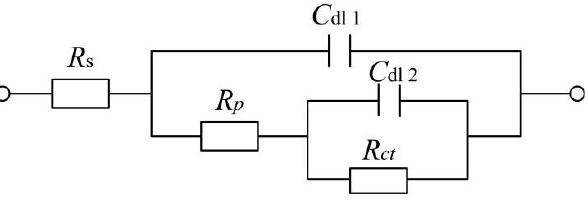
Figure 7. Equivalent circuits to fit. Table 4. Characteristic of the equivalent circuit derived from the EIS